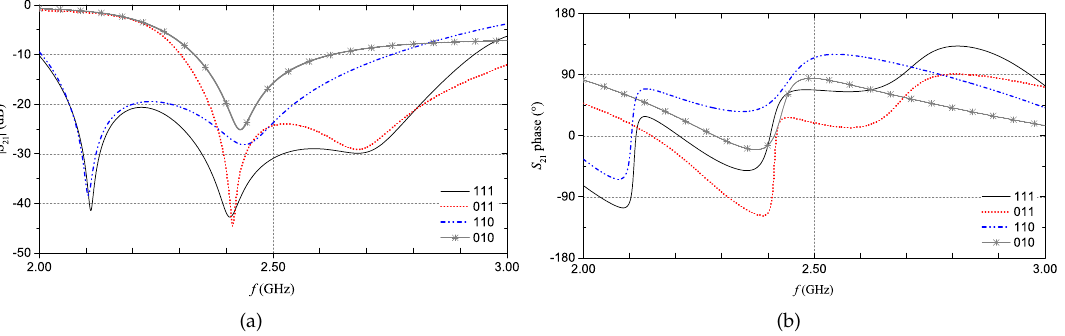
Figure 4. Multi-stopband structure. S 21 simulations results for four coding configurations: magnitude ( a ) and phase ( b ). c (cid:13) [2019] IEEE. Reprinted, with permission, from